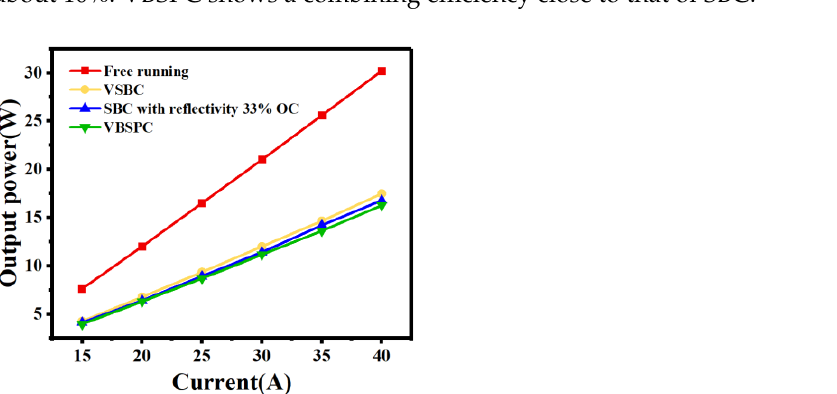
Figure 3. The power–current characteristics of free running (red), SBC at an OC with reflectivity of 33% (blue), VSBC with maximum output power (yellow), and VBSPC (green). The M 2 factors in the fast axis (M 2 y ) and slow axis (M 2 x ) of a single emitter